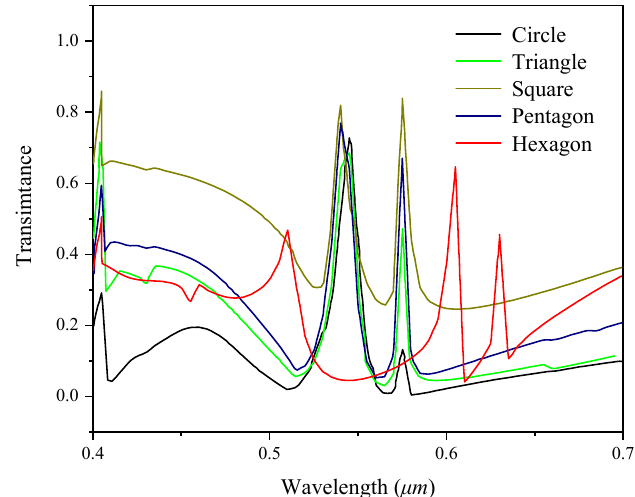
Figure 2. The influence of different grating shapes on spectral response (grating depth 𝐻 = 0.04 µm, SiO 2 waveguide layer thickness 𝐻 1 = 0.08 µm, Si 3 N 4 waveguide layer thickness 𝐻 2 = 0.1 µm, duty ratio F = 0.65, grating period Λ = 0.25 µm).